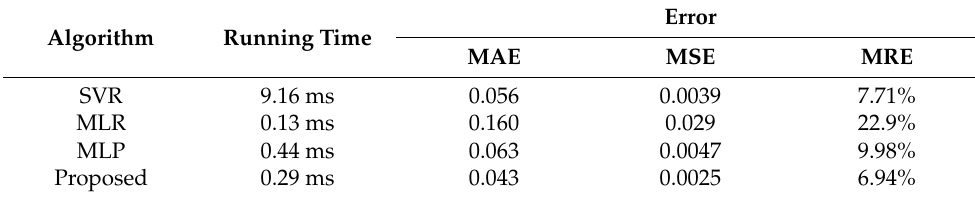
Table 5. Comparison of prediction results of different